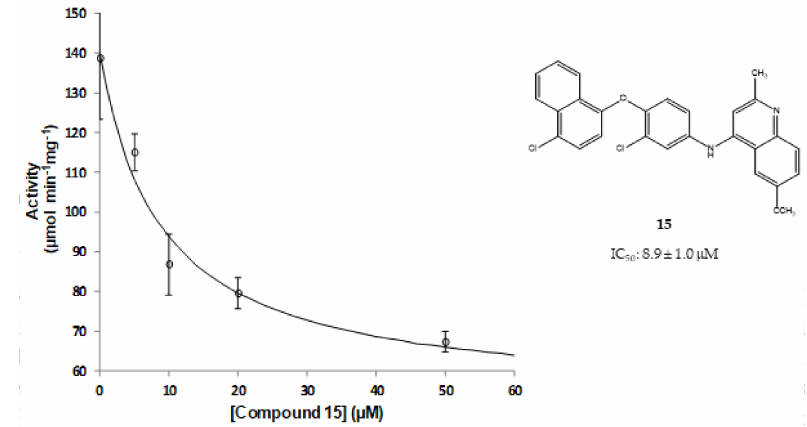
Figure 6. Steady-state analyses of the activity of NDH-2 from S. aureus in the presence of compound 15